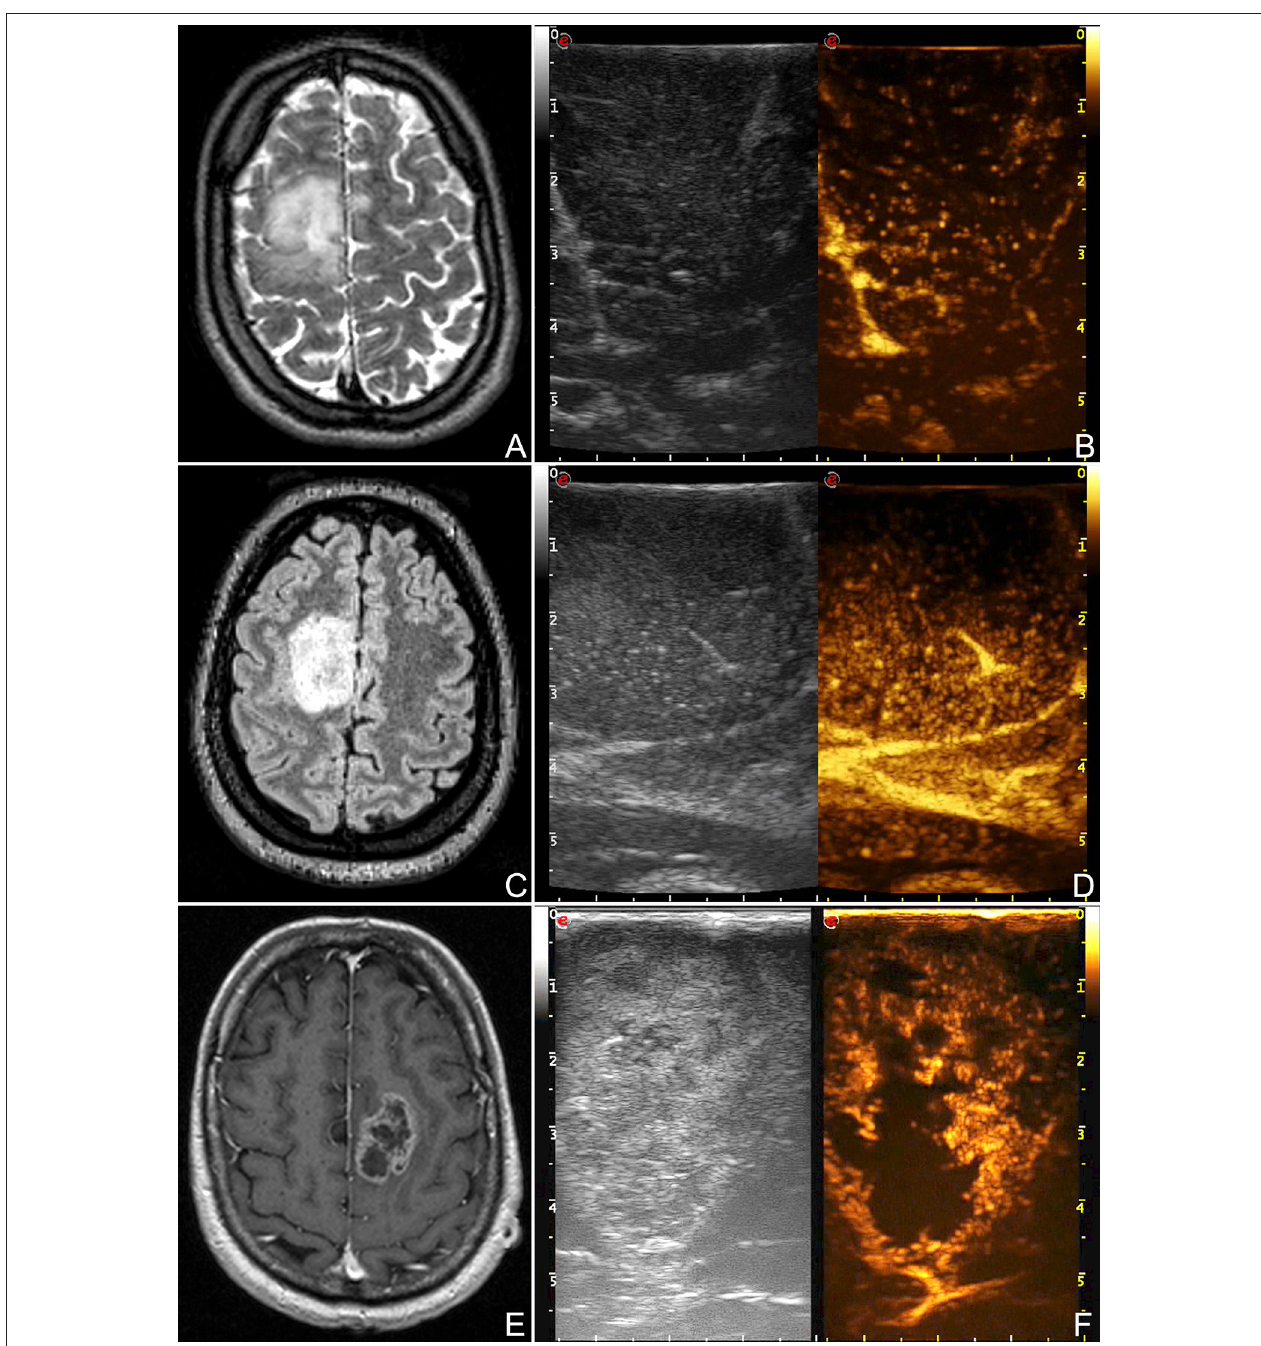
FIGURE 6 | CEUS representation of different glioma grades. (A,B) Right frontal low-grade glioma, (C,D) right frontal anaplastic astrocytoma, (E,F) left frontal glioblastoma. These images demonstrate the different degree and pattern of contrast enhancement among different glioma